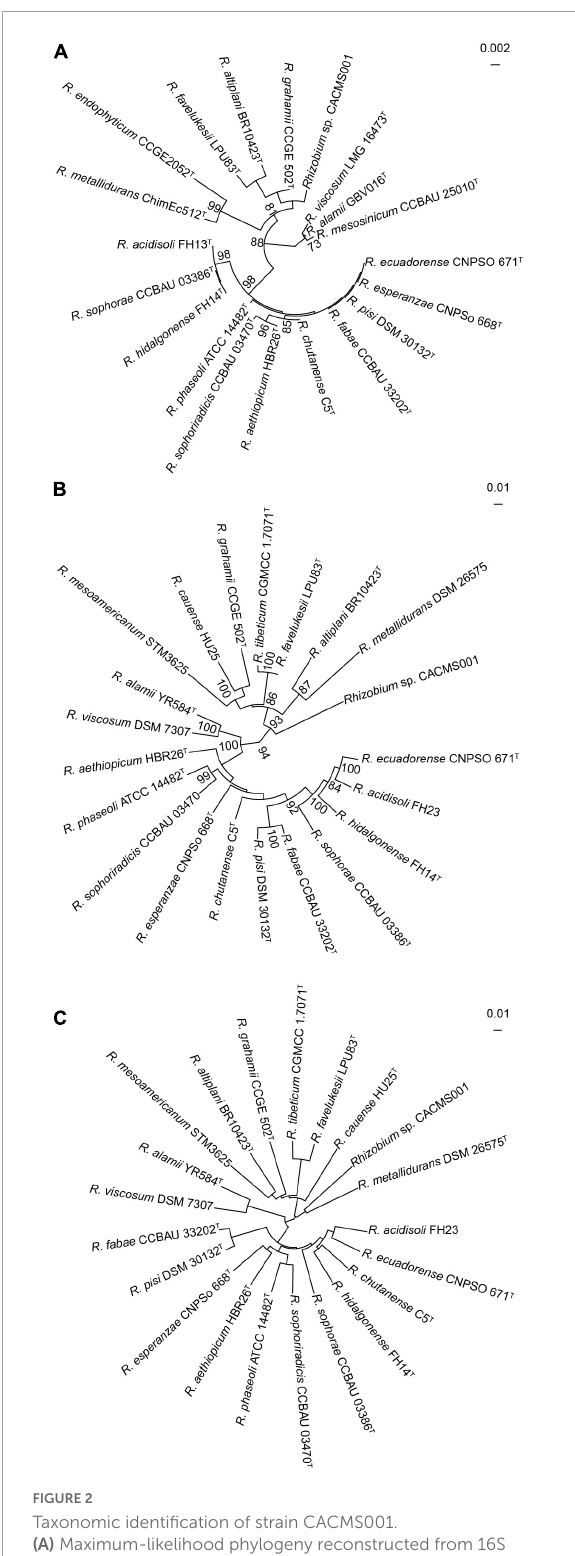
FIGURE2 Taxonomic identification of strain CACMS001. (A) Maximum-likelihood phylogeny reconstructed from 16S rRNA gene. (B) Maximum-likelihood phylogeny reconstructed from concatenated recA , atpD , glnII , and rpoB genes. (C) Neighbor-joining phylogeny reconstructed from